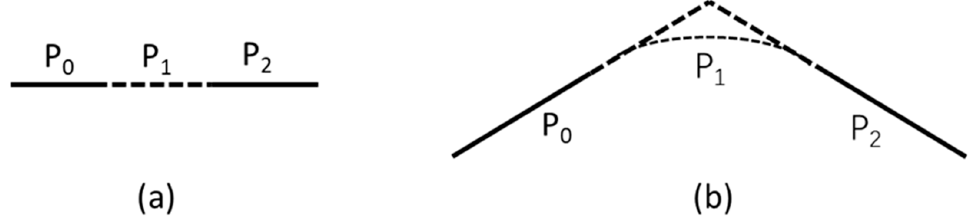
Figure 8. Schematic diagram of curb refinement on unconnected boundaries. ( a ) The curb which connected by a straight area. ( b ) The curb which connected by a curve fitting area.